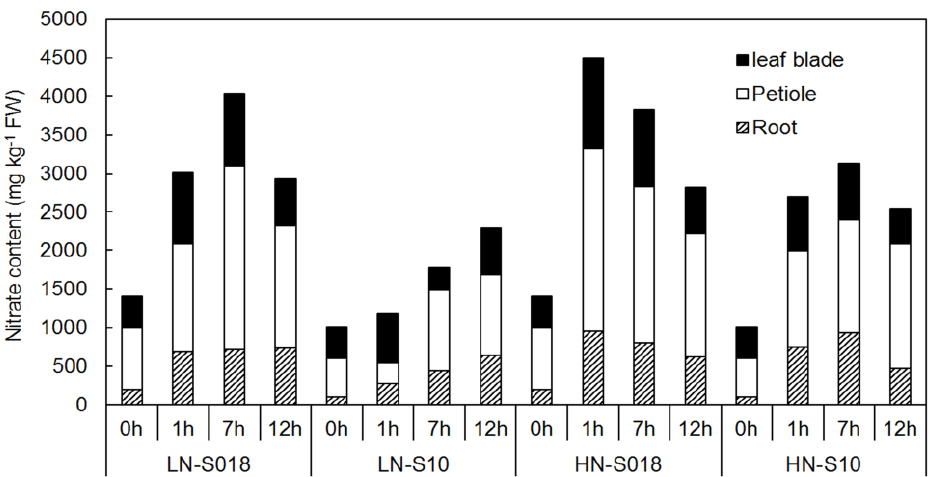
Figure 2. Nitrate contents in tissues of two spinach varieties under low (0.5 mmol·L −1 ) and high (15 mmol·L −1 ) nitrate treatments. LN-So18, So18 treated with low nitrate concentration; LN-So10, So10 treated with low nitrate concentration; HN-So18, So18 treated with high nitrate concentration; and HN-So10, So10 treated with high nitrate concentration.